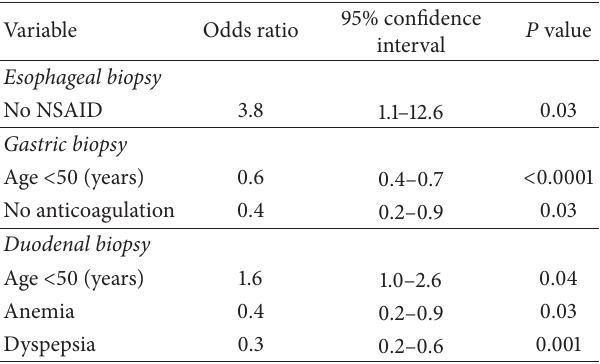
Table 4: Clinical predictors of abnormal biopsy on macroscopically normal EGDs on multivariable logistic